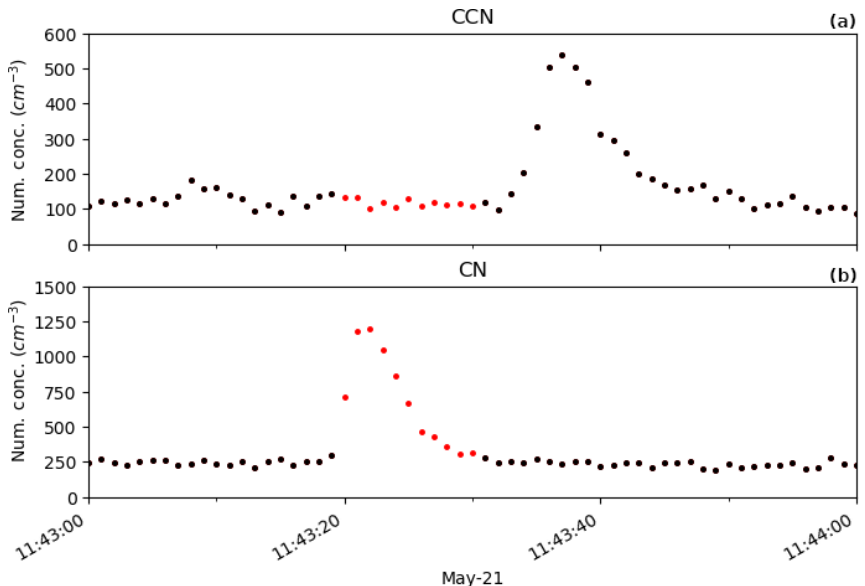
Figure A10. Time series of 1min of time-synchronised aerosol data. Unfiltered data in red, with black markers showing exhaust-filtered data. The exhaust is clearly identified in the CN data but due to differences in instrument residence time, the exhaust signal shows up 10s later in the CCN data, in this case, after the exhaust signal has ceased in the CN. While it is possible to align the underlying datasets based on an exhaust event, rather than by time, application of this method is unsuitable for this context because of the range of instrumentation where this exhaust product would be utilised (and thus the range of responses), and because the window filter applied after identification would result in a negligible improvement.